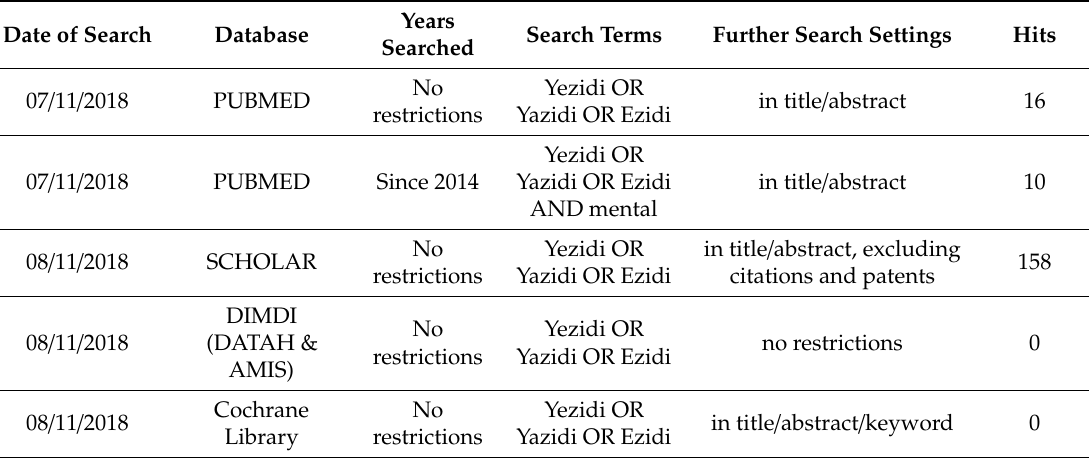
Table 1. Literature search tracking